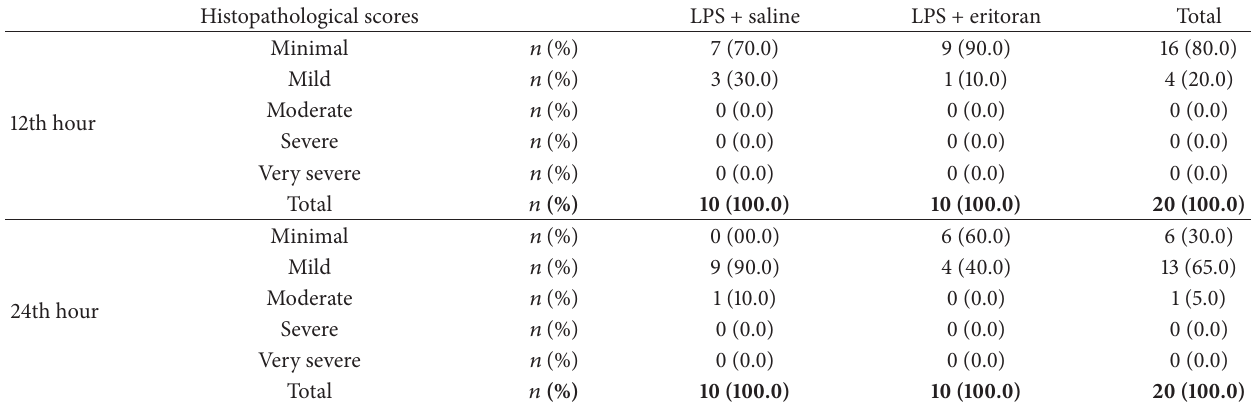
Table 2: Histopathological scores of study groups.